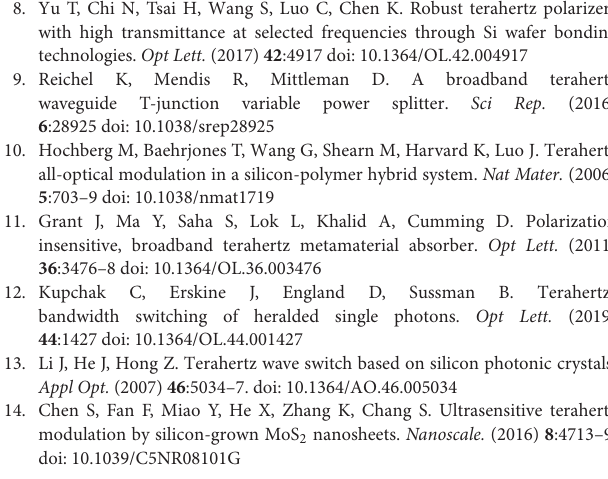
obtained by experiment and calculation. One sees that the CsPbBr 3 -QD-embedded metasurface has low saturation pump laser intensity and high extinction ratio factor as a potential method to actively control the terahertz wave transmission.